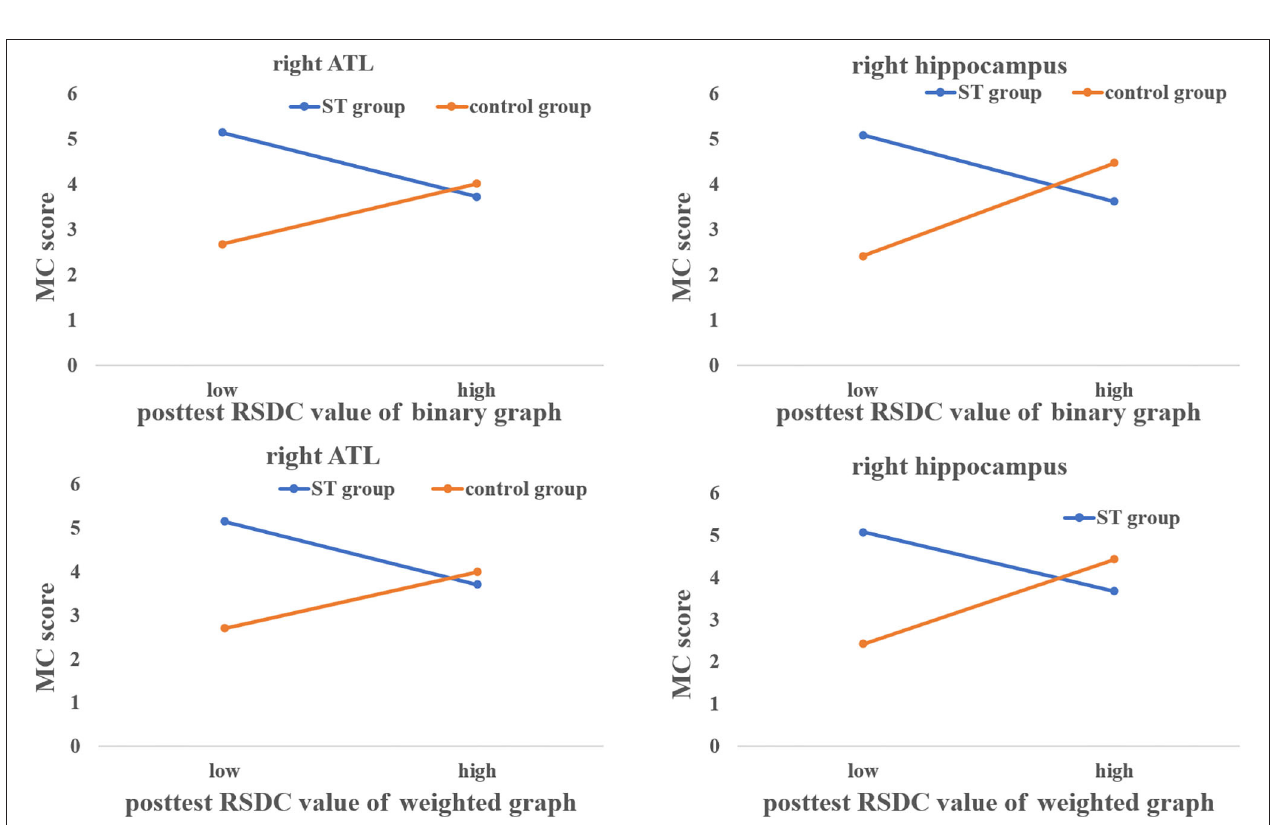
and ventral parietal cortex (VPC), where the DPC includes the intraparietal sulcus and SPG, and the VPC includes the supramarginal and angular gyri (Cabeza, 2008; Cabeza et